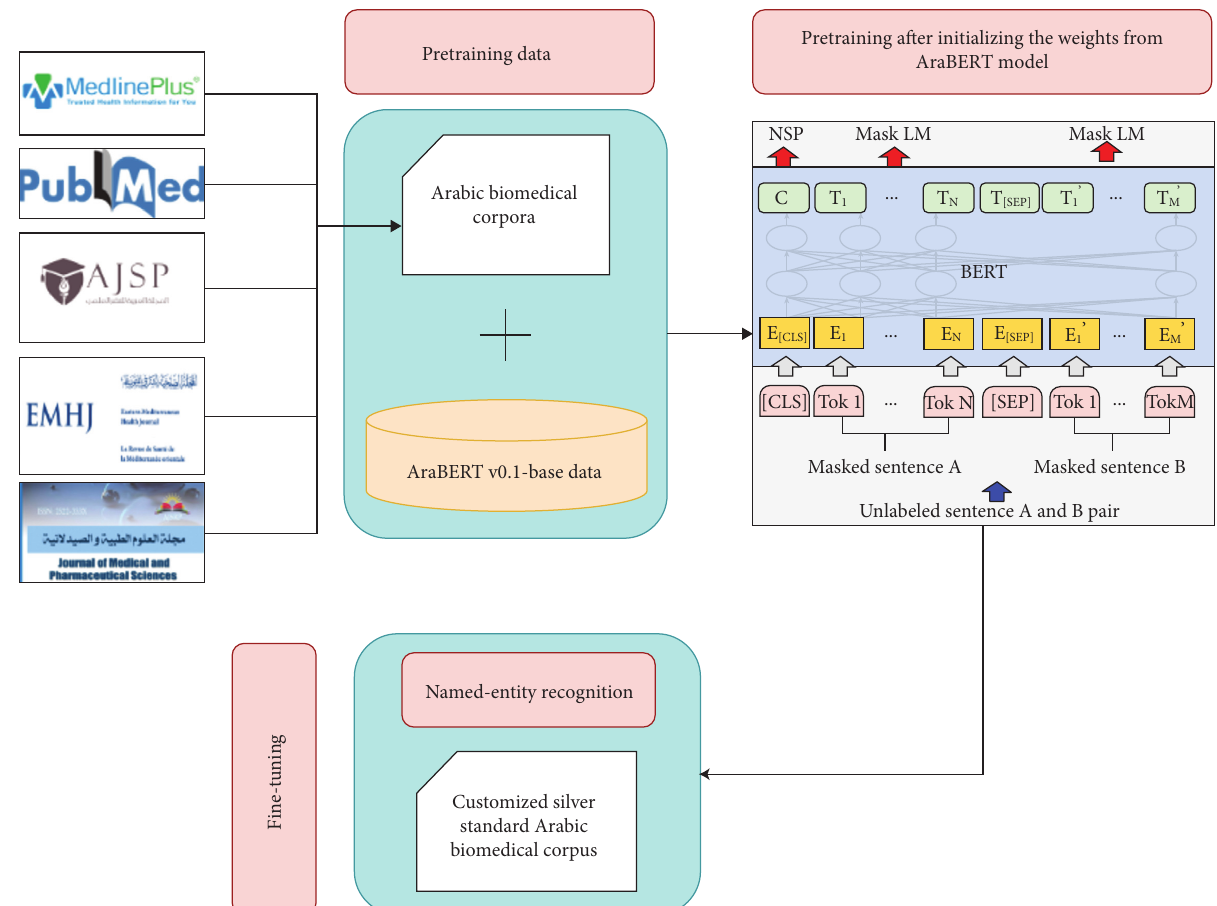
Figure 1: Overview of ABioNER model.